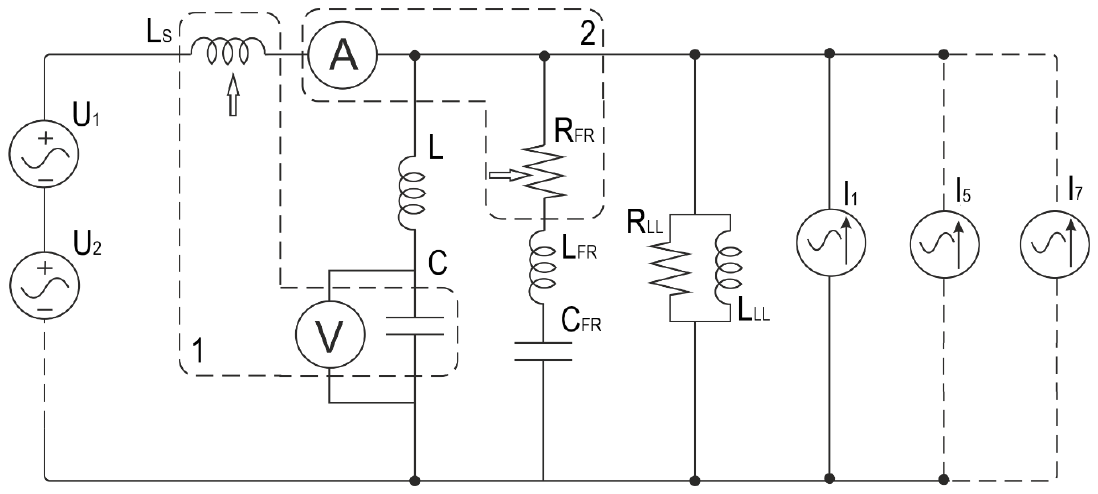
Figure 2. A scheme displaying the principle of harmonic source detection methods.